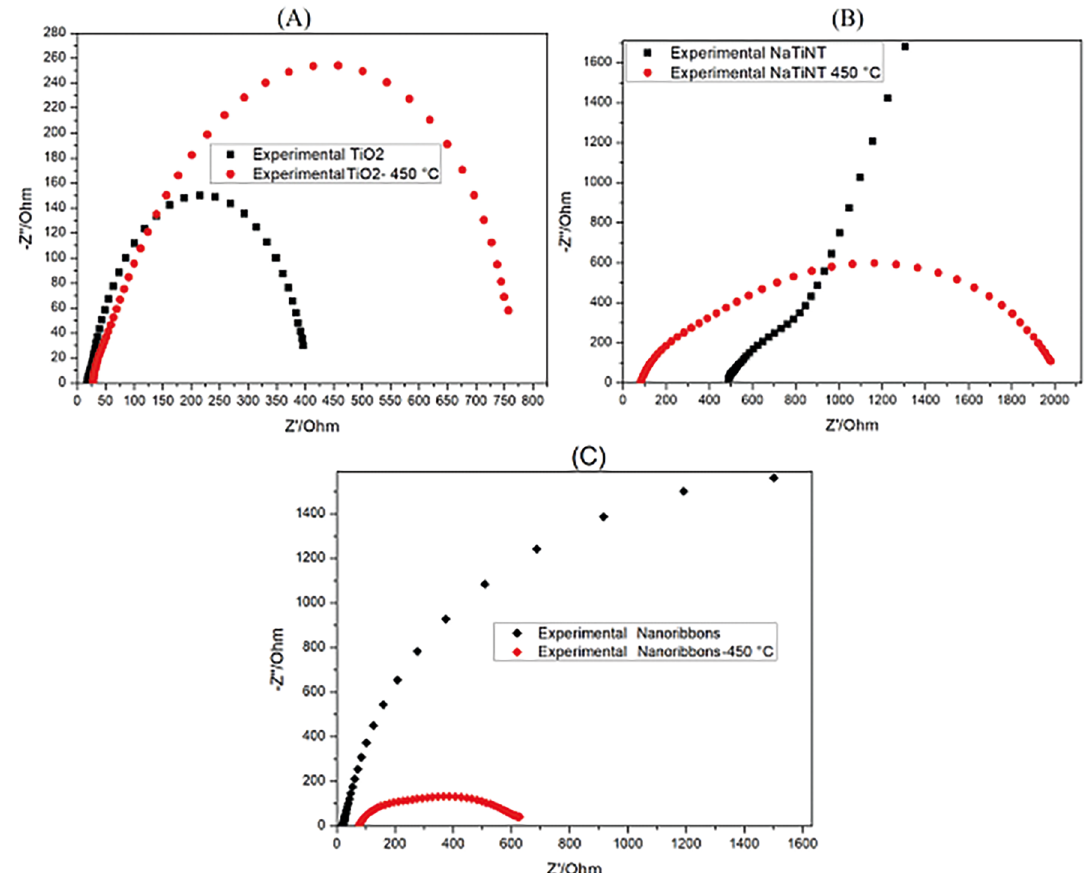
/TiO -450 °C; B) NaTiNT/NaTiNT-450 °C and C) Nanoribbons/ 2 2